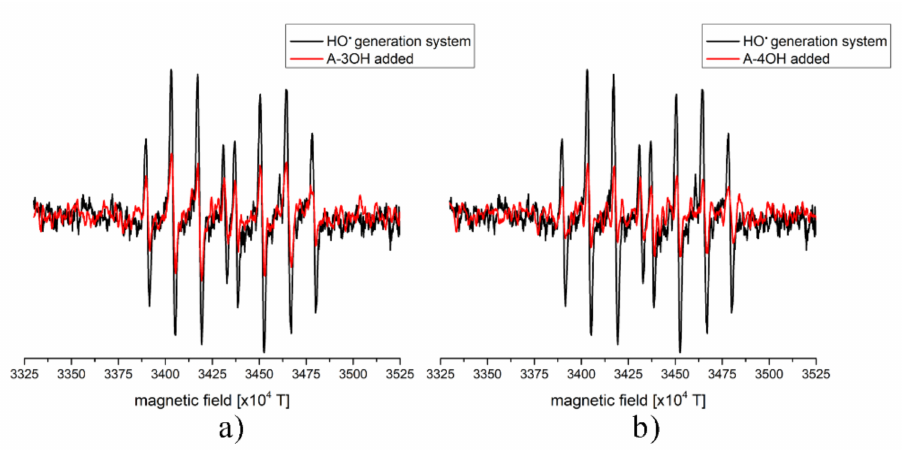
Figure 1. The experimental EPR spectra of DEPMPO-HO • with and without compounds ( a ) A-3OH and ( b ) A-4OH .